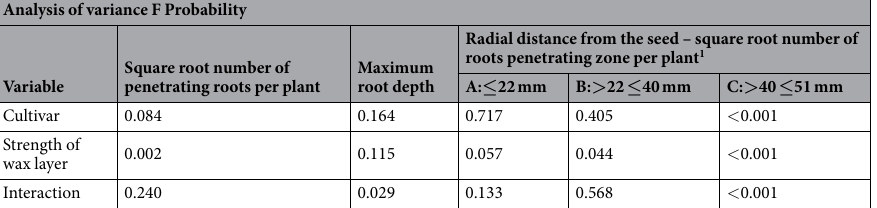
Table 4. Analysis of variance summary table for number of roots penetrating the wax layer, maximum root depth and radii zones of penetration in a controlled environment wax layer experiment comparing root growth between Cadenza and Hereward in sand columns challenged with either strong or weak paraffin wax layers at 5 cm depth from the surface. 1 Zone A: diameter 44 mm; zone B: diameter 45–80 mm and zone C: diameter 81–102 mm.